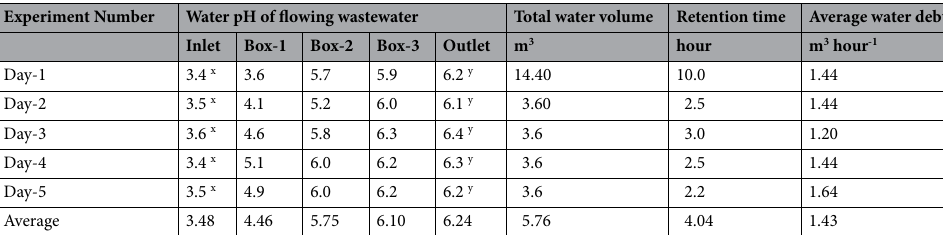
Table 3. Data of pH monitoring on inlet, box-1, box-2, box-3, and outlet on day 1 until day 5 of experiment. Note: x = is not comply and y = is comply with